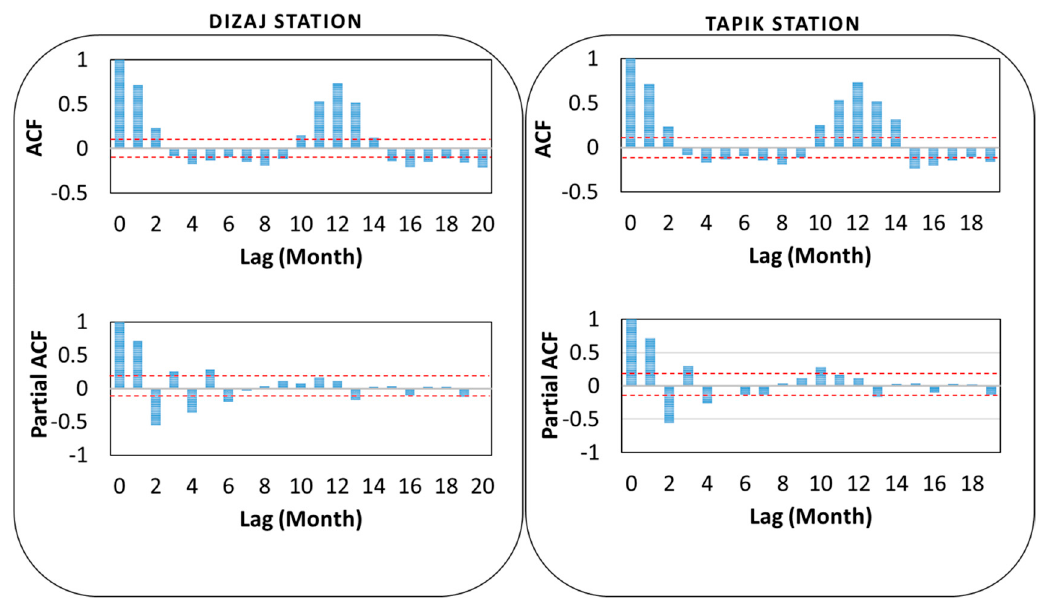
Figure 4. The autocorrelation function (ACF) and partial autocorrelation function (PACF) for the streamflow variable at Dizaj and Tapik stations.